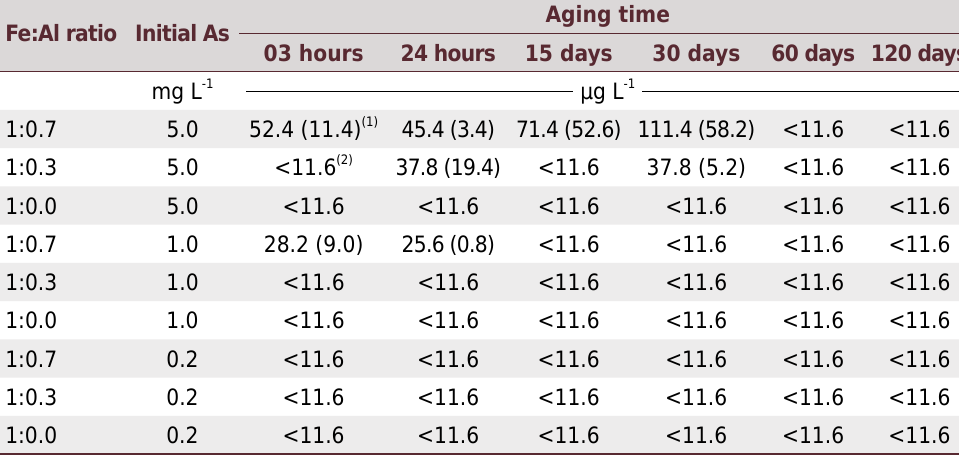
(1) Numbers between brackets are the two-sigma standard deviation of replicates. (2) The number after the symbol < means the detection limit of the analytical